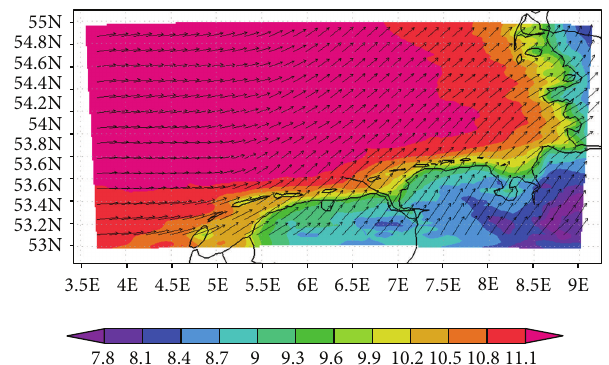
Figure 7: Average wind speed (m/s) and wind direction at 100 m height over the 3 km WRF modelling domain during March 2005 when the MYNN PBL scheme was selected.